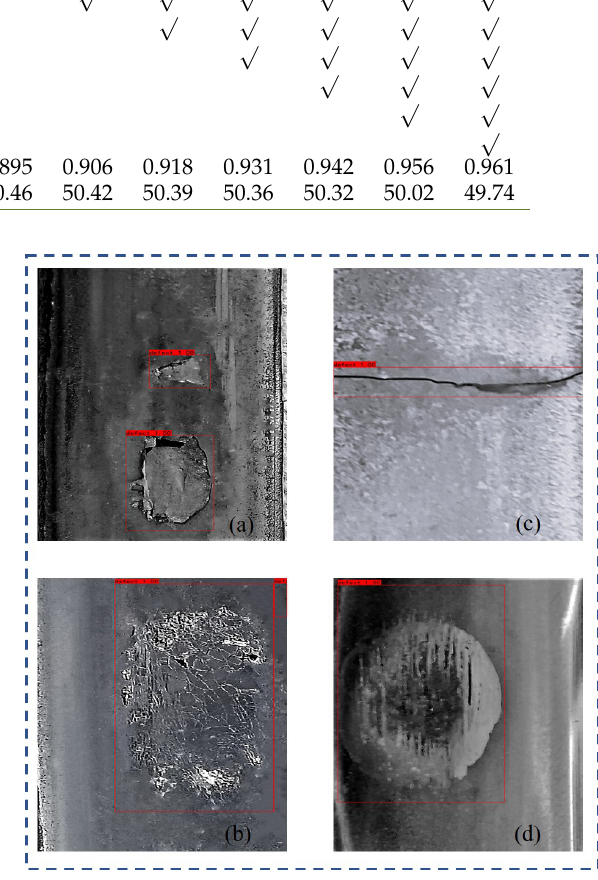
Fig. 13. The detection results with proposed algorithm. (a) Rail surface drop block result. (b) Rail surface